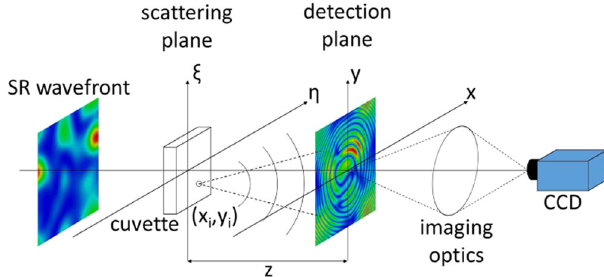
FIG. 1. Typical HNFS experimental setup. A SR wavefront impinges onto a quartz cuvette containing many scattering particles suspended in a liquid at random positions ð x i ; y i Þ